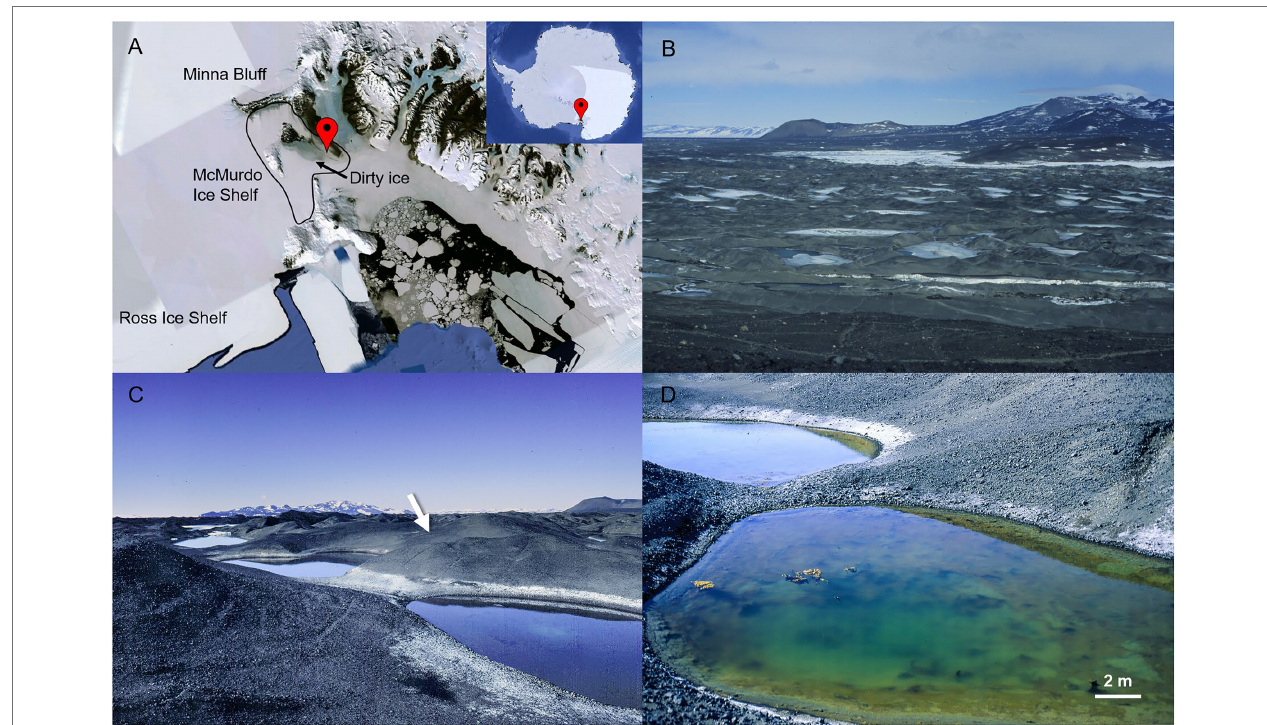
FIGURE 1 | McMurdo Ice Shelf (MIS) close to the coast of Bratina Island. In (A) , geographic location of the MIS in Antarctica (image of Google Earth). In (B) , a view of the MIS from the top of Bratina Island showing the debris coated-ice of the surface (“dirty ice”) and numerous seasonal meltwater ponds (some ice-capped). In (C) , location of the desiccated microbial mat in a hillside of a mound at the time of collection (indicated with a white arrow). In (D) , one of the meltwater ponds closest to the location of the desiccated microbial mat. Active microbial mats are observed in the meltwater